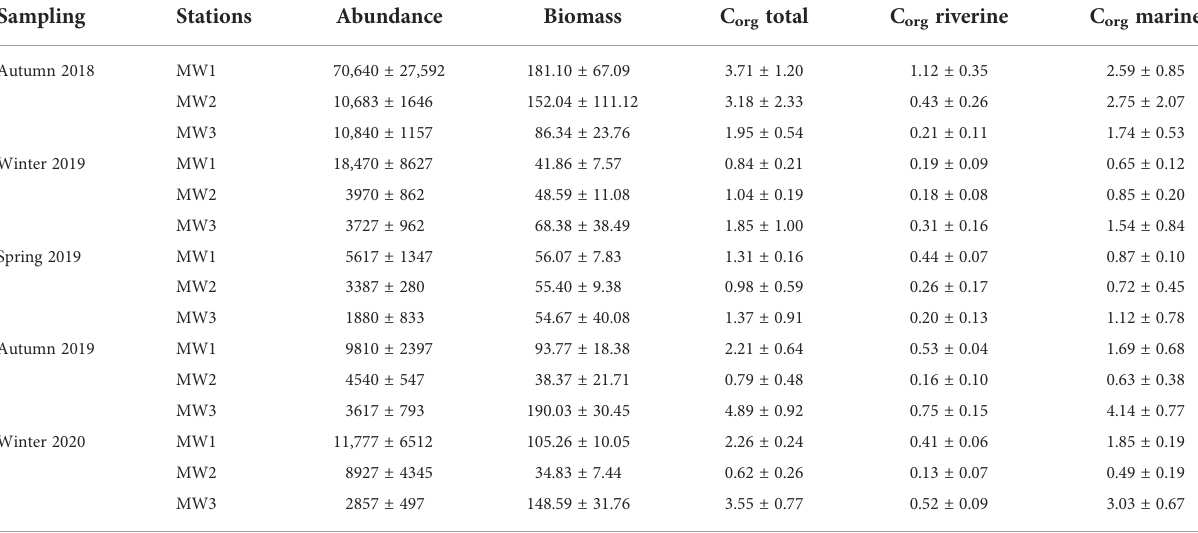
TABLE 4 The abundance [ind. m -2 ], biomass [g WW m -2 ] and total, riverine, and marine C org contents [g DW m -2 ] in benthic communities among stations and sampling campaigns. Sampling Stations